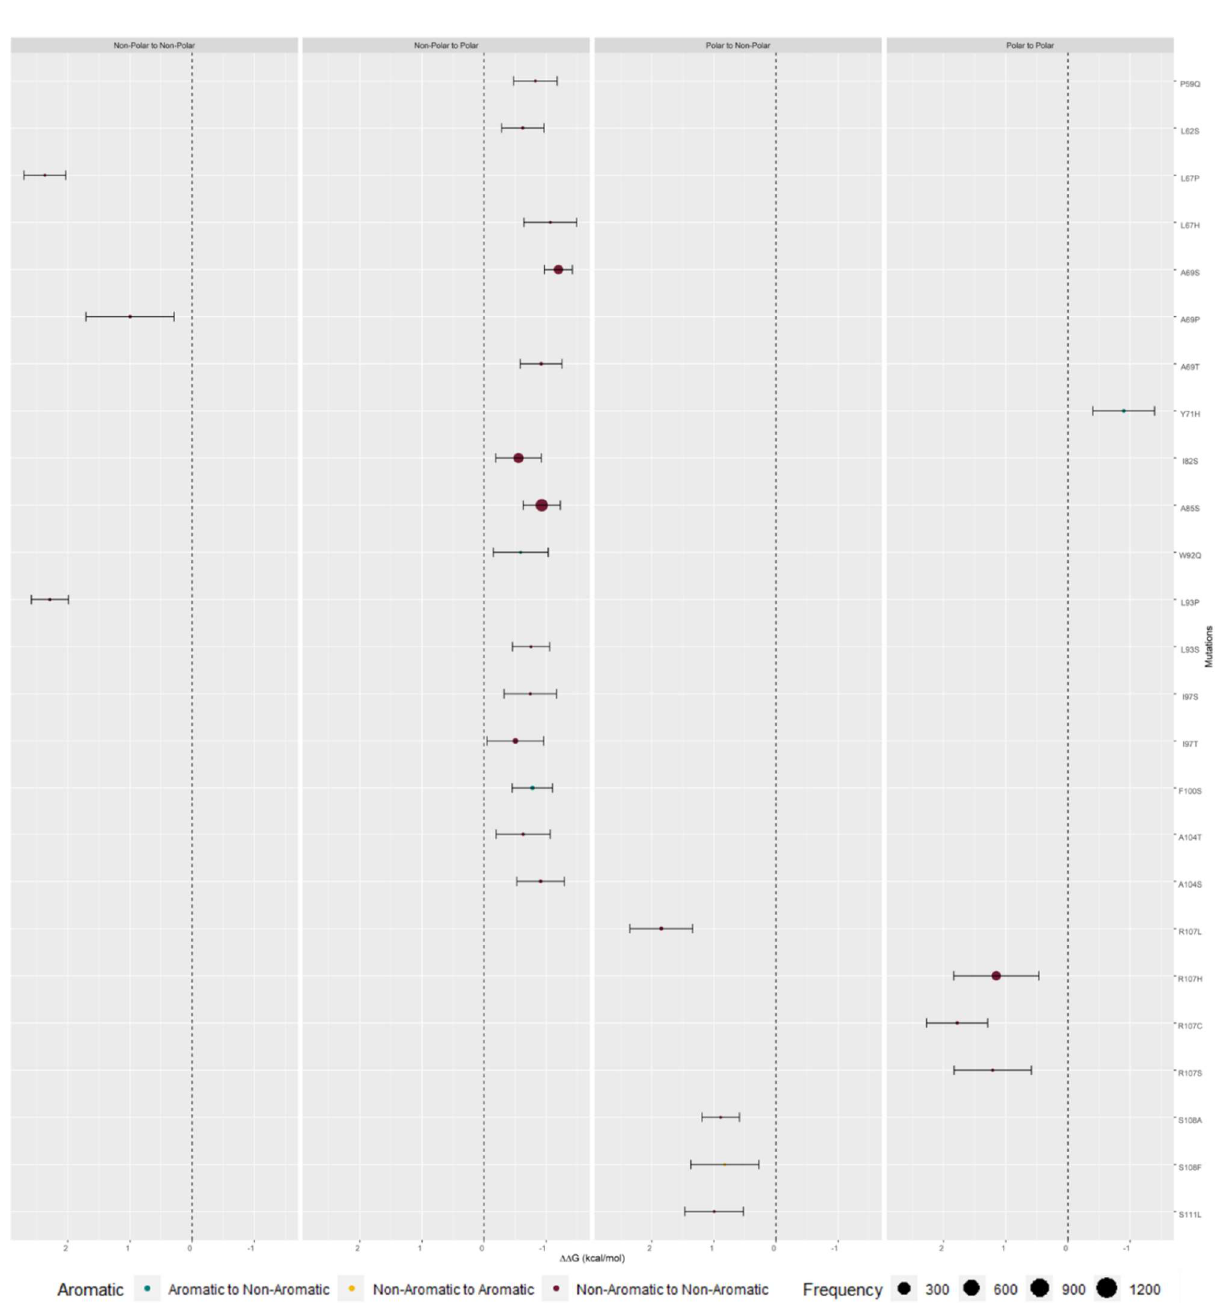
Figure 6. ΔΔG binding values of predicted interfacial residues that possessed mutations capable of causing major impact in protein stability. Color represents the alteration from aromatic to non-aromatic (teal), non-aromatic to aromatic (yellow), and non-aromatic to non-aromatic (garnet) (all the presented results are mean values ± standard deviation).